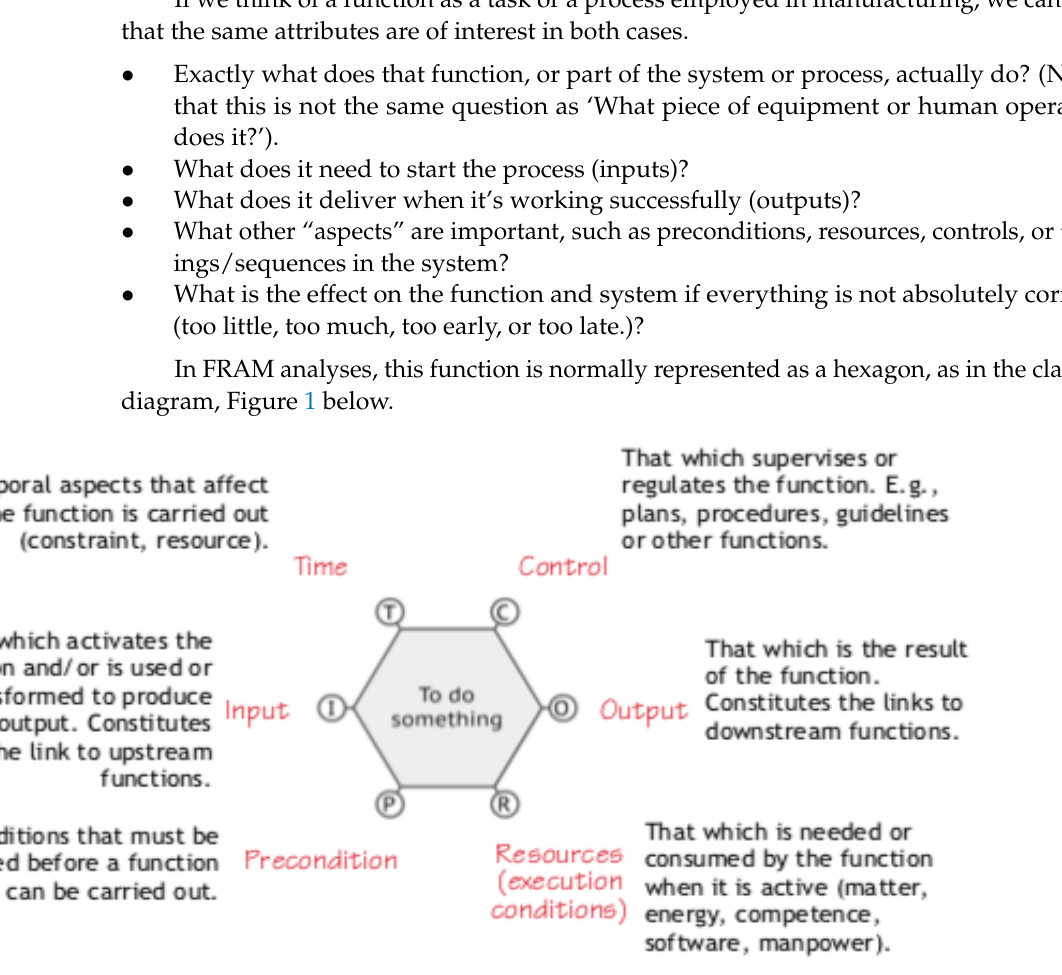
Figure 1. The different aspects of a FRAM function—after Hollnagel. But until now there has not been a way of answering those other important questions that OR needs as data (Figure